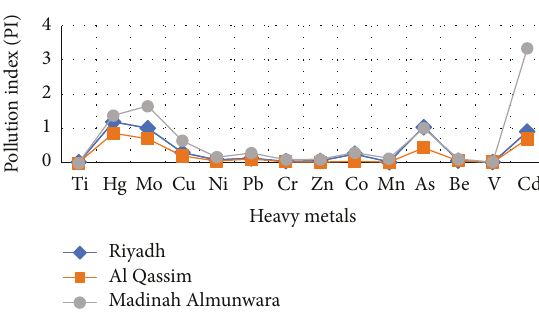
Figure 3: Variations of PI value in the soil samples from Riyadh, Qassim, and Medina.